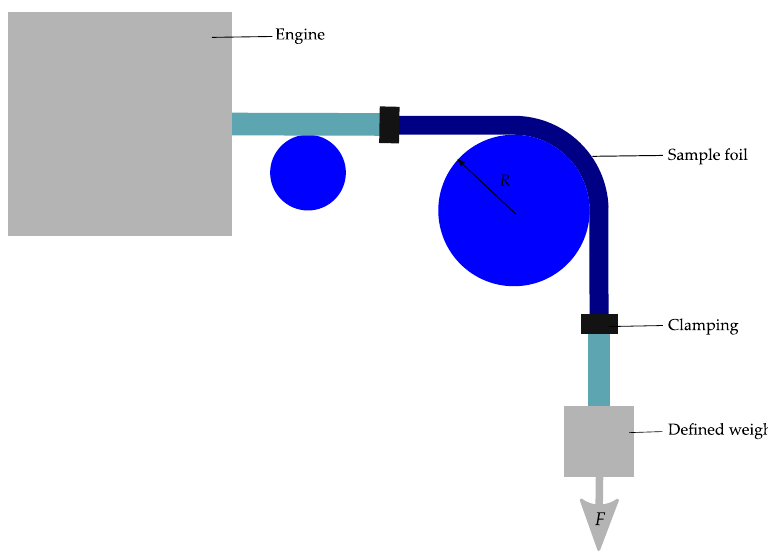
Figure 18. Dynamic bending machine. Modified and freely sketched after [93].